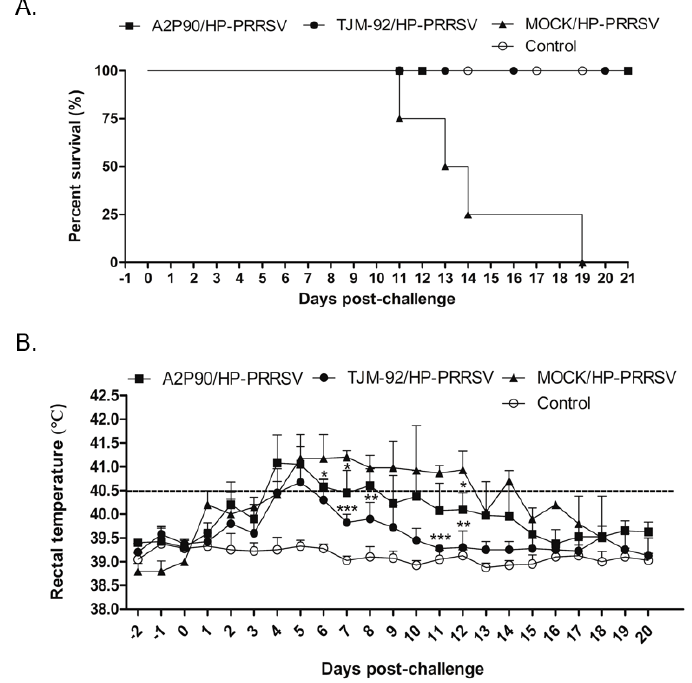
Figure 2. PRRSV-A2MC2-P90 protection of piglets against a lethal challenge with highly pathogenetic PRRSV (HP-PRRSV). ( A ). All vaccinated animals or non-vaccinated controls were each inoculated with 1.0 × 10 5 TCID 50 of HP-PRRSV-XJ1 via both intramuscular and intranasal routes. Clinical signs and survival rates were monitored and calculated daily for a total of 21 days. ( B ). After inoculation of animals, rectal temperature was recorded daily for surviving animals of all groups. Data are expressed as mean ± SD and were subjected to a Student’s t -test. Significant differences between the A2MC2-P90-vaccinated group (A2P90/HP-PRRSV), TJM F92-vaccinated group (TJM-92/HP-PRRSV) and the non-vaccinated but the HP-PRRSV challenged group (MOCK/HP-PRRSV) are marked with * ( p < 0.05), or ** ( p < 0.01) or *** ( p < 0.001).